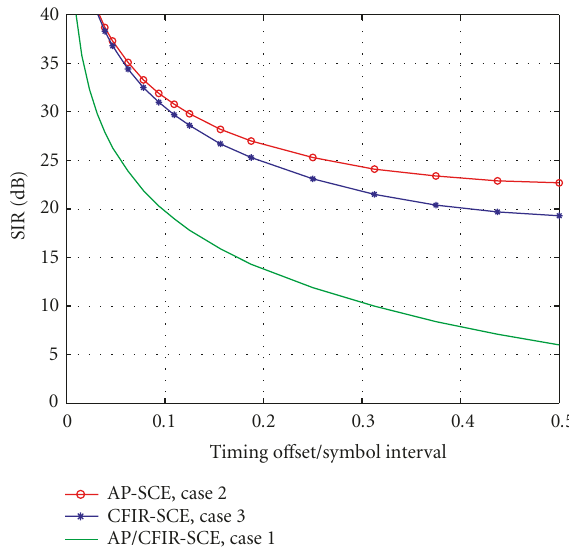
Figure 10: Semi-analytic SIR due to timing phase o ff set in AP-SCE and CFIR-SCE in an ideal